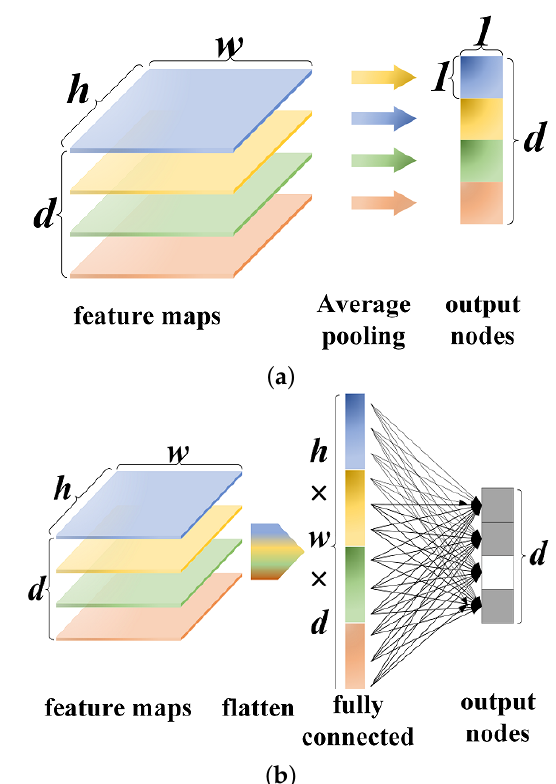
Figure 1. Comparison of feature mapping layers. ( a ) FC layer, ( b ) GAP